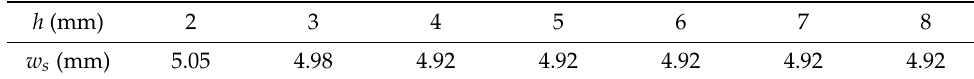
Figure 9. B x of the leakage magnetic field ( h = 2~8 mm). Figure 9. Bx of the leakage magnetic field (h = 2~8 mm). Peak distance w s in Figure 9 is shown in Table 1. Peak distance w s in Figure 9 is shown in Table 1. Table 1. w s values in Figure 8. Table 1. w s values in Figure 8.